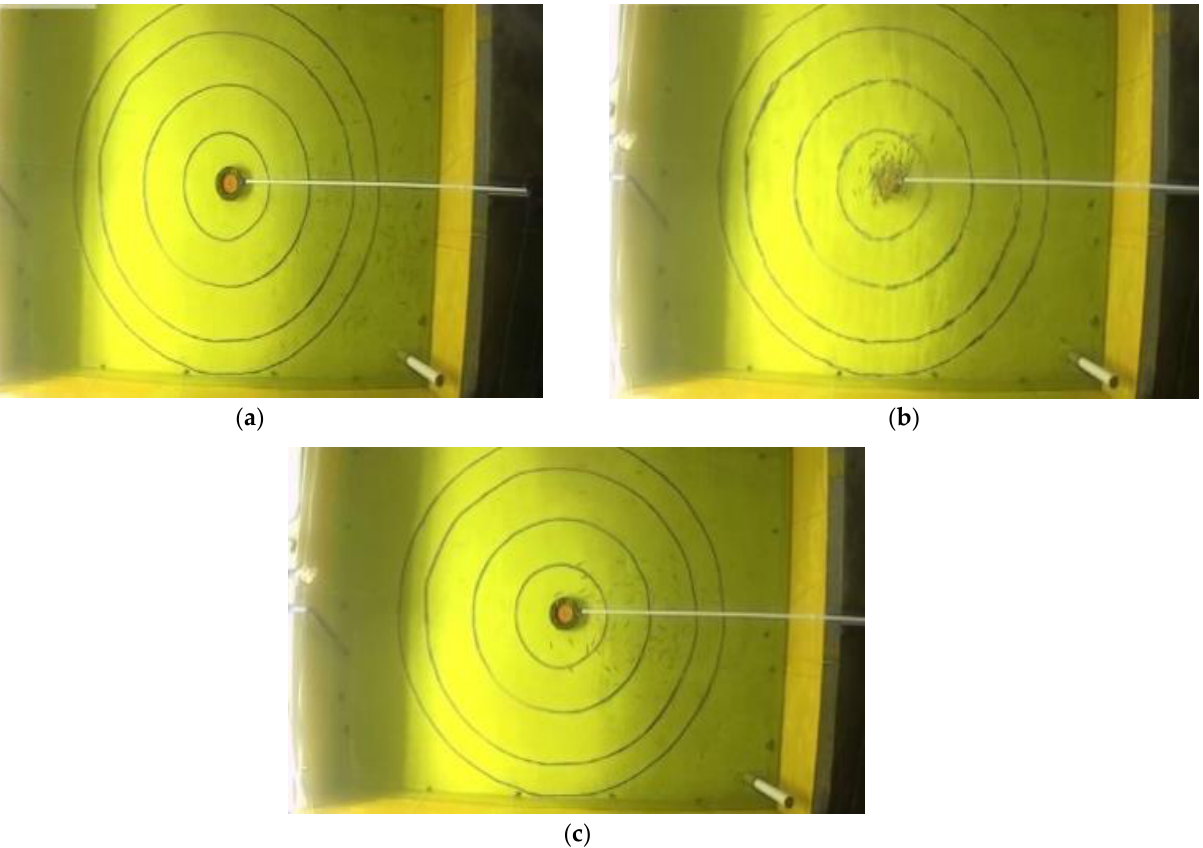
Figure 8. The behavioral responses of juvenile Pagrus major before the sound was played ( a ), when sound was playing ( b ), and after the sound had finished playing ( c ).